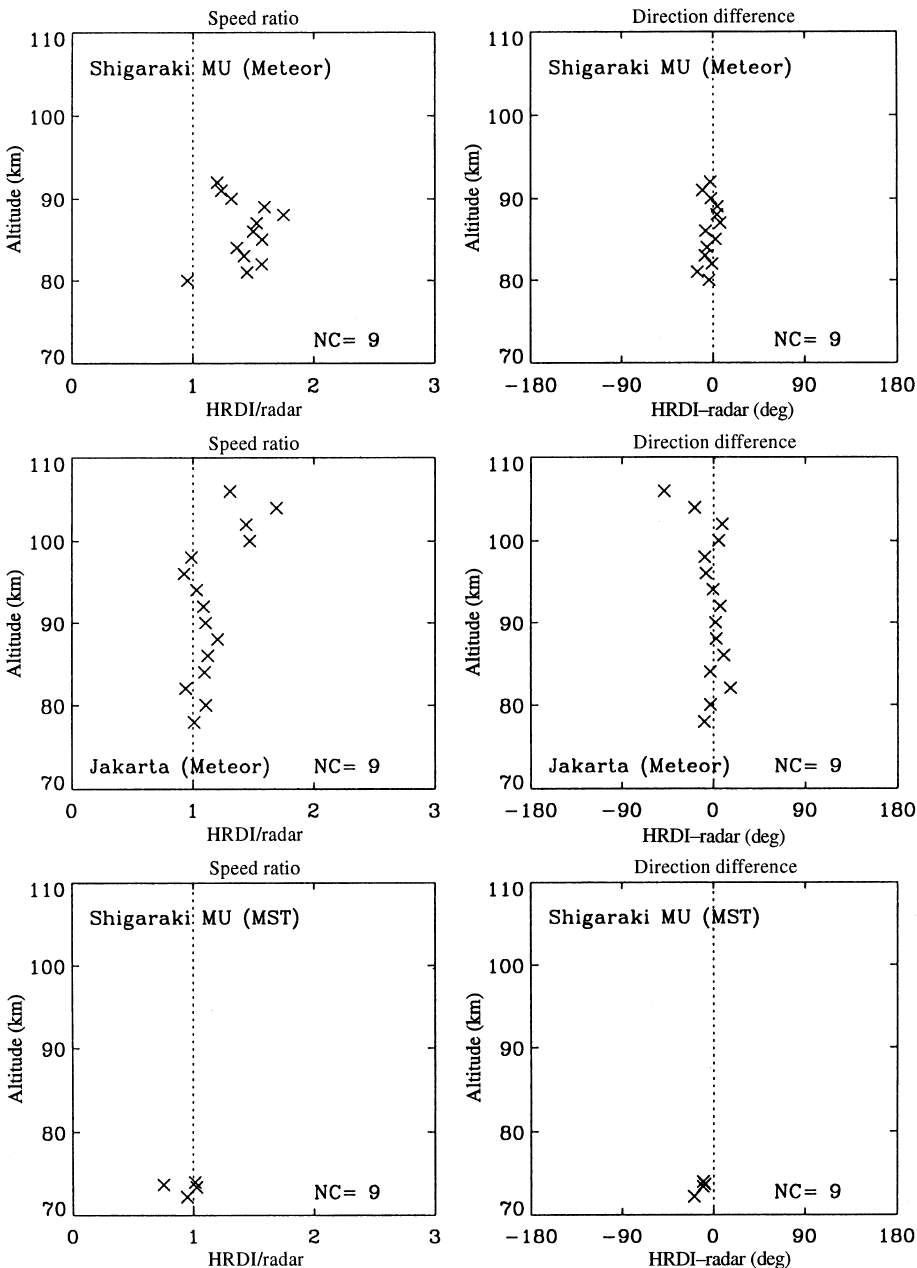
Fig. 6. Vertical profiles of the median of the speed ratio (HRDI/radar) and the direction di(cid:128)erence (cid:133) HRDI (cid:255) radar